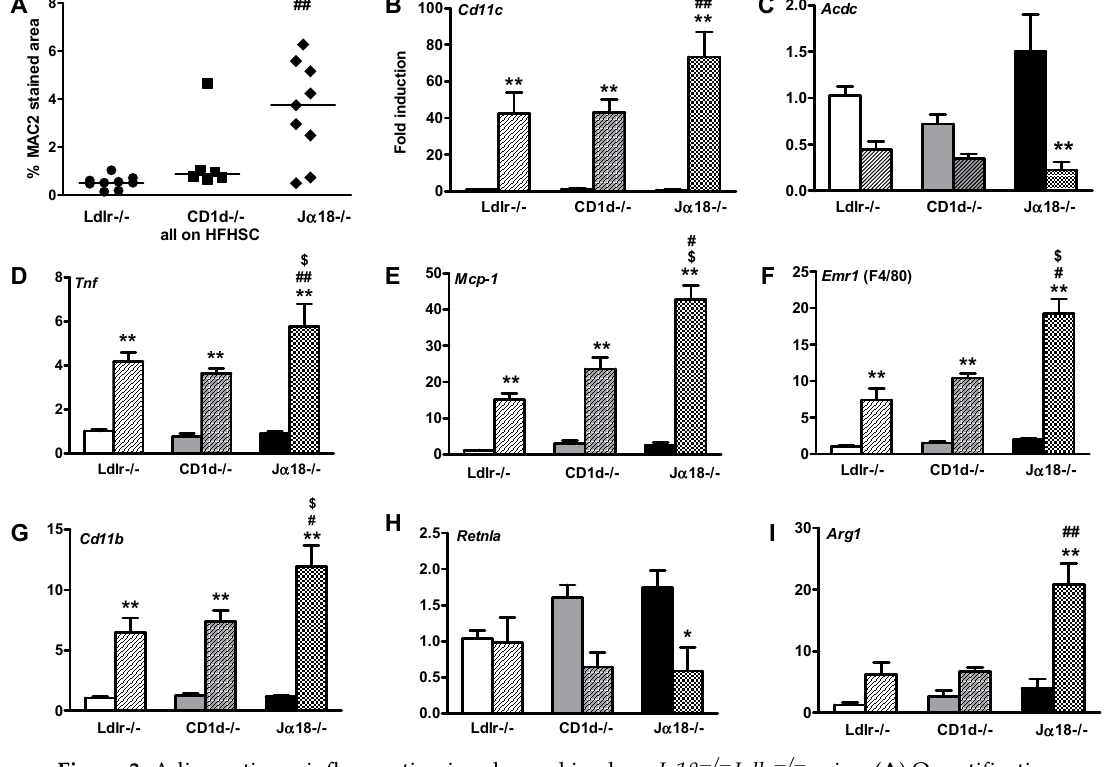
Figure 3. Adipose tissue inflammation is enhanced in obese Ja18 − / − Ldlr − / − mice. ( A ) Quantification of macrophage Mac2 staining of adipose tissue; ( B – I ) Expression level of genes in whole perigonadal adipose tissue expressed relative to lean chow-fed Ldlr − / − mice. n = 5–10 per group. * p < 0.05 vs. corresponding lean group, ** p < 0.01 vs. corresponding lean group, # p < 0.05 vs. HFHSC-fed Ldlr − / − mice, ## p < 0.01 vs. HFHSC-fed Ldlr − / − , $ p < 0.05 vs. HFHSC-fed Cd1d − / − Ldlr − / − mice. Solid bars—chow-fed animals; closed symbols and hatched bars—HFHSC-fed animals.